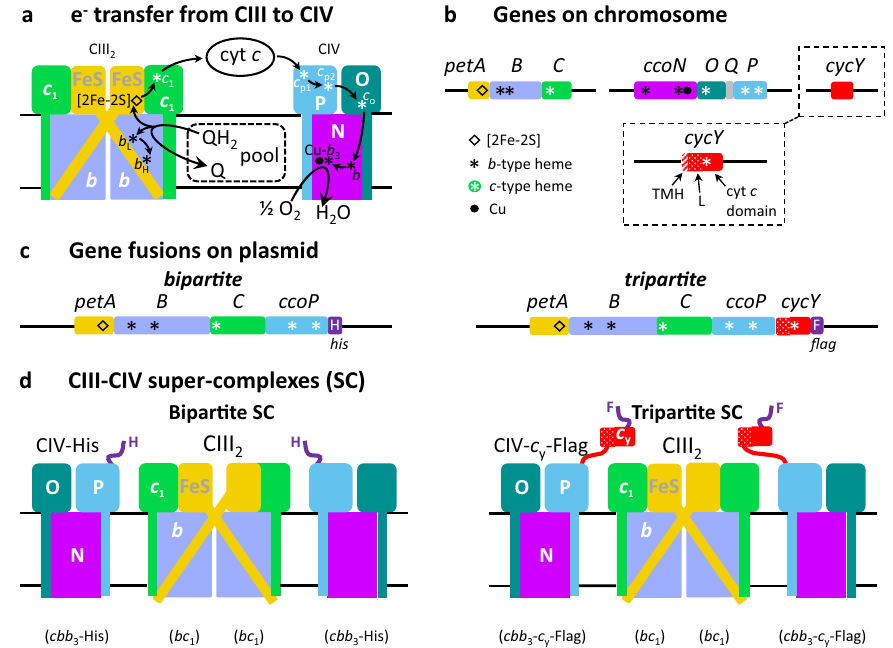
Fig. 1 QH 2 oxidation and fused SCs. a Bifurcated electron transfer reaction conveys one electron from QH 2 oxidation to the FeS protein (FeS, yellow) [2Fe- 2S] cluster and another electron to cyt b (periwinkle) hemes b L and b H . Reduced [2Fe-2S] cluster transfers the electron to cyt c 1 (green) heme c 1 via the movement of the FeS protein from near heme b L to near heme c 1 . The subsequent electron transfer step from heme b H to Q from the pool is not shown for clarity. A cyt c ( c 2 or c y ) carries electrons from heme c 1 to CIV, where electrons reach the heme-Cu (Cu -b 3 ) site, where O 2 is reduced to H 2 O, via the CcoP (P, light blue) hemes c p1 and c p2 , CcoO (O, dark green) heme c o , and CcoN (N, purple) heme b . b R. capsulatus petABC encodes the structural genes of the bc petA , yellow), cyt b ( B , periwinkle), and cyt c C , green), and ccoNOQP encodes those of the cbb 1 -type CIII 2 subunits, the FeS protein ( 1 ( 3 -type CIV subunits, the CcoN ( ccoN , purple), CcoO ( O , dark green), CcoQ ( Q , gray), and CcoP ( P , light blue). cycY gene (red) encodes cyt c y , and its 30-residue transmembrane helix (TMH), 69-residue linker (L), and 100-residue cyt c (cyt c ) domain are indicated. Heme cofactors of b - and c -type cyts are